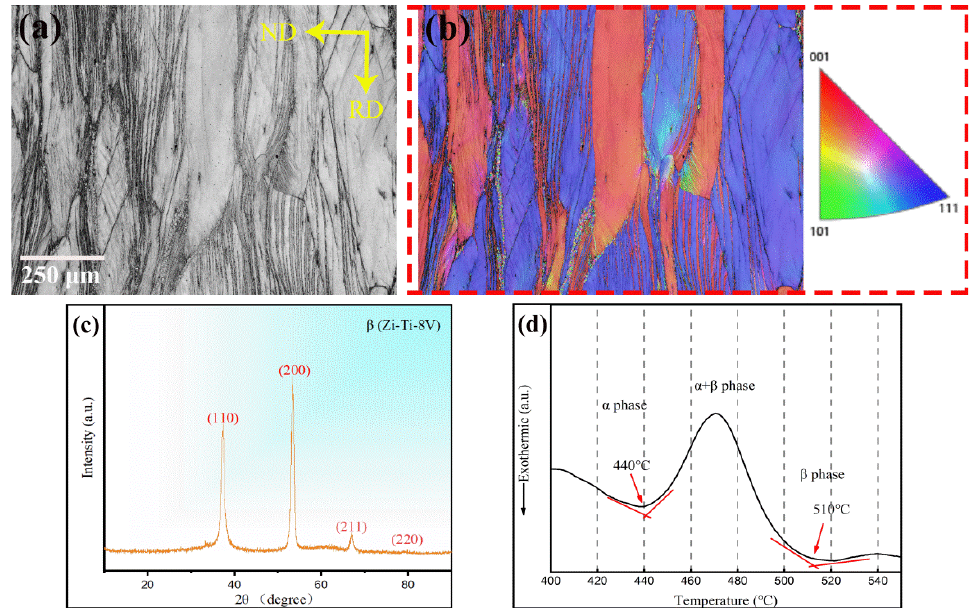
Figure 1. ( a , b ) EBSD orientation image of 450 °C of hot-rolled Zr – Ti – 8V alloy; ( c ) XRD pattern of hot-rolled Zr – Ti – 8V alloy; ( d ) DSC curve of Zr – Ti – 8V alloy.